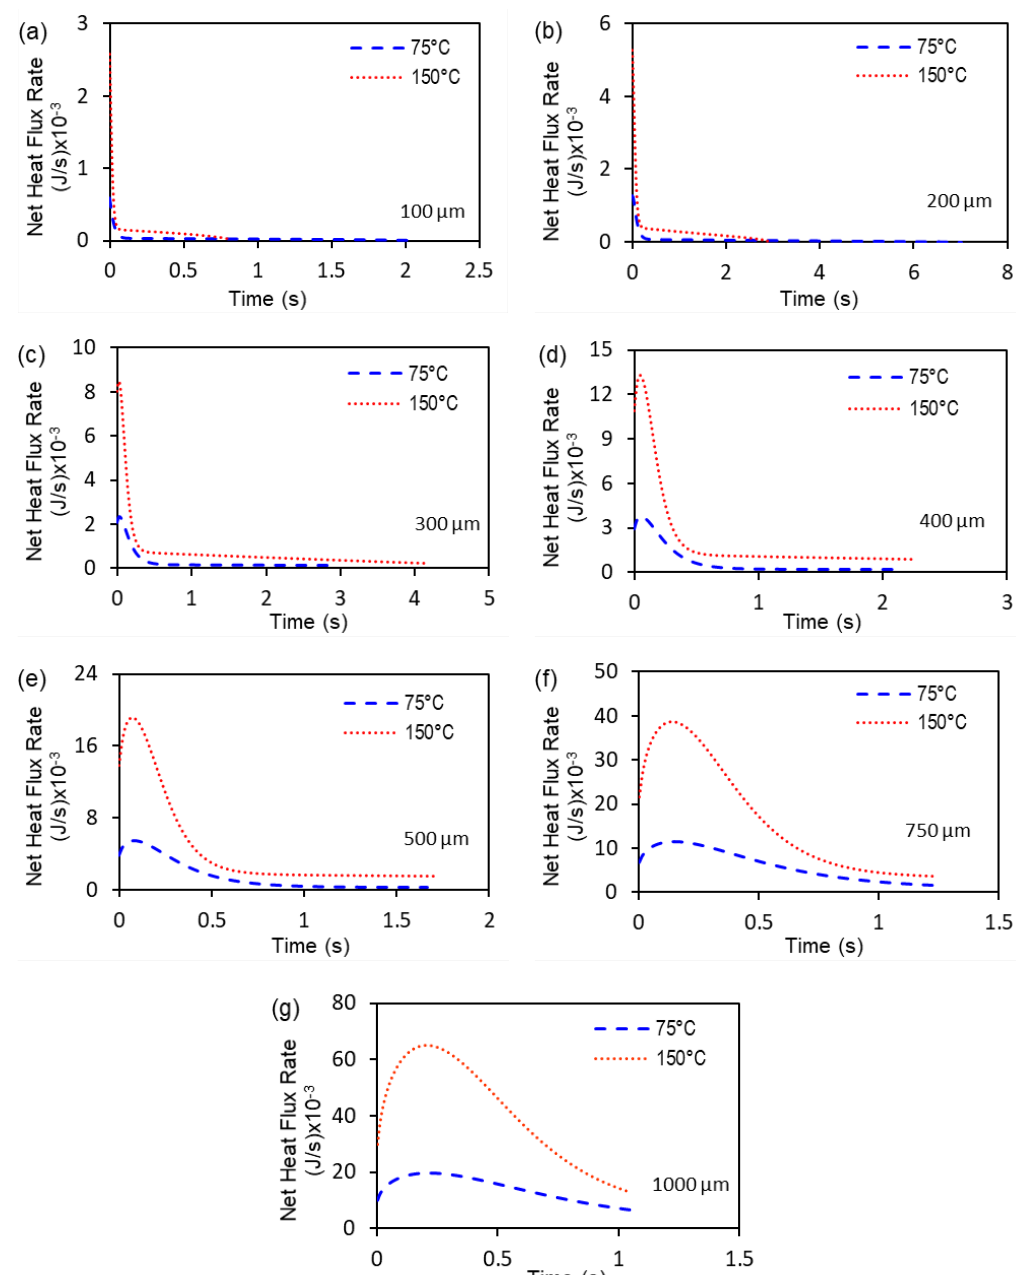
Figure 8. The net heat flux rate in the droplets for condition 1 and 2; ( a ) 100 µm; ( b ) 200 µm; ( c ) 300 µm; ( d ) 400 µm; ( e ) 500 µm; ( f ) 750 µm; and ( g ) 1000 µm.